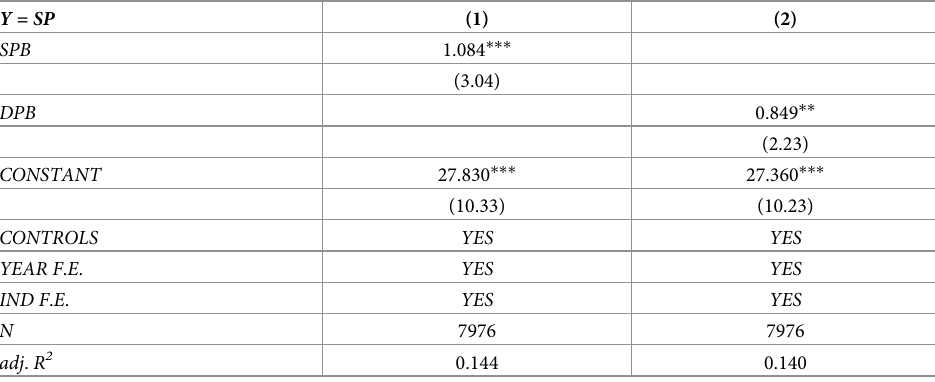
Table 10. The test of the balance effect mechanism.